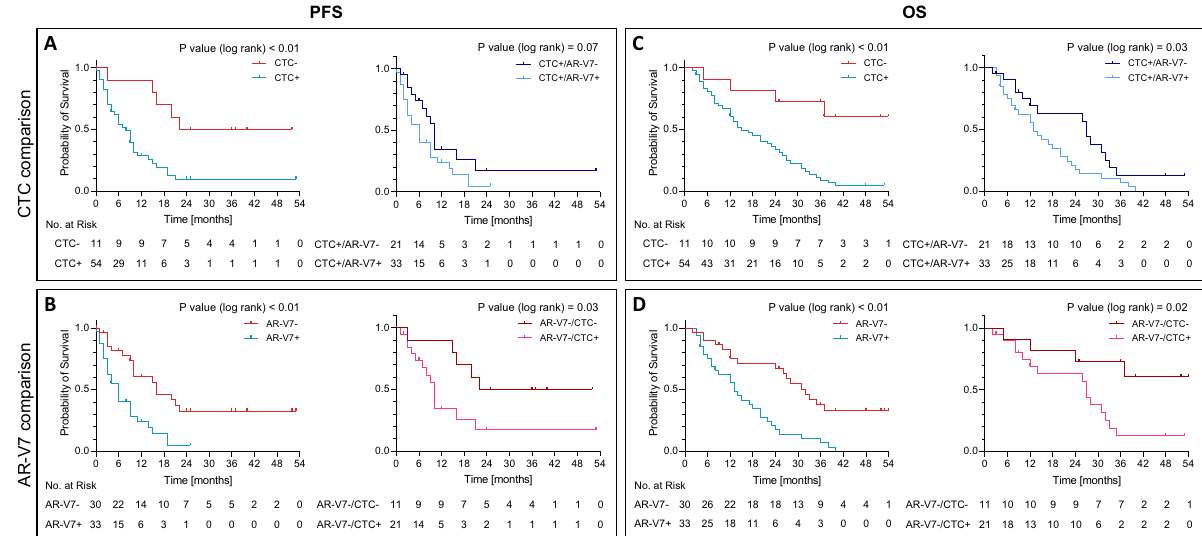
Figure 3. Progression free survival and overall survival. Kaplan–Meier curves including patient numbers at risk indicating PFS according to CTC status ( A ) and AR-V7 status ( B ) of patients undergoing ARTA treatment. ( A , left panel) For the overall cohort, median PFS was 22 months (CI not estimable) and 8 months (CI 5.5–10.5) for CTC − patients and CTC + patients, respectively ( p < 0.01). ( A , right panel) Within the CTC + cohort, median PFS was 10 months (CI 8.9–11.1) and 6 months (CI 3.6–8.4) for AR-V7- patients and AR-V7 + patients, respectively, without statistical significance ( p = 0.07). ( B , left panel) For the overall cohort, median PFS was 16 months (CI 7.0–25.0) and 6 months (CI 3.6–8.4) for AR-V7- patients and AR-V7 + patients, respectively ( p < 0.01). (B, right panel) Within the AR-V7- subgroup, median PFS was 22 months (CI not estimable) and 10 months (CI 8.9–11.1) for CTC − patients and CTC + patients, respectively ( p = 0.03). Kaplan–Meier curves including patient numbers at risk indicating OS according to CTC status ( C ) and AR-V7 status ( D ) of patients undergoing ARTA treatment. ( C , left panel) For the overall cohort, median OS was not reached for CTC − patients and 15 months (CI 8.7–21.3) for CTC + patients ( p < 0.01). ( C , right panel) Within the CTC + cohort, median OS was 27 months (CI 25.1–28.9) and 13 months (CI 9.2–16.8) for AR-V7- patients and AR-V7 + patients, respectively ( p > 0.01), without statistical significance ( p = 0.07). ( D , left panel) For the overall cohort, median OS was 31 months (CI 25.2–36.8) and 13 months (CI 9.2–16.8) for AR-V7- patients and AR-V7 + patients, respectively ( p < 0.01). ( D , right panel) Within the AR-V7- subgroup, median OS was not reached and 27 months (CI 25.1–28.9) for CTC − patients and CTC + patients, respectively, ( p =